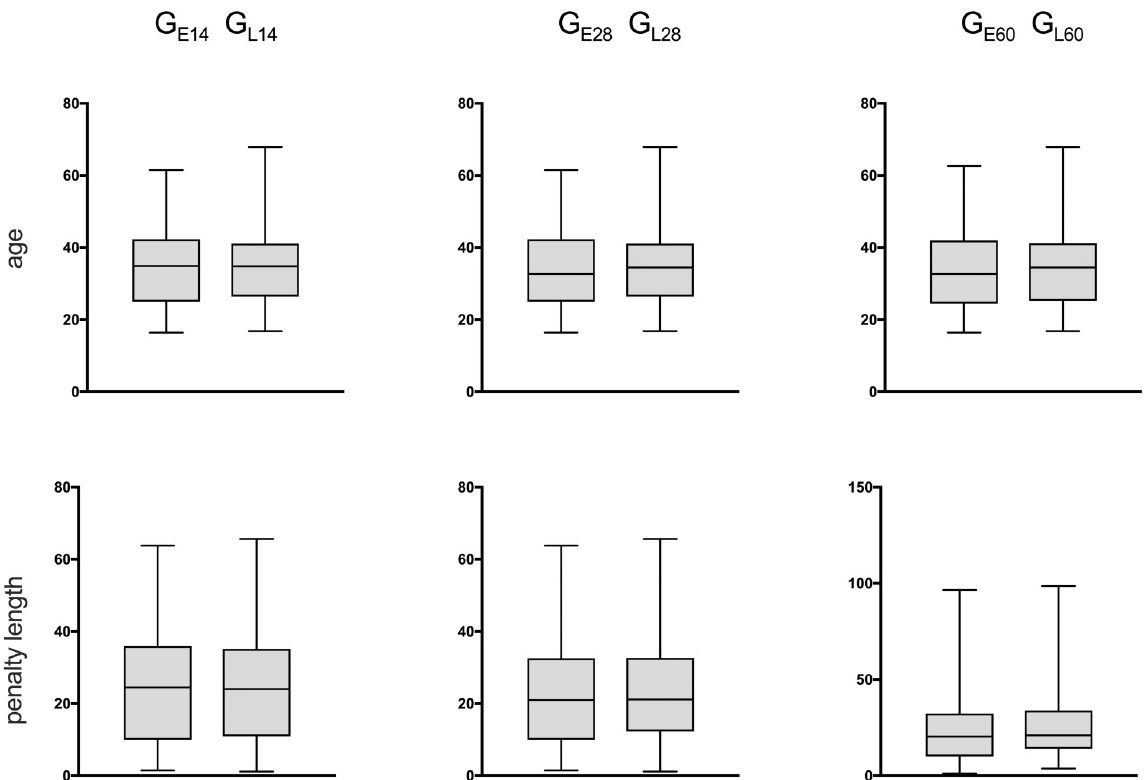
Fig 1. Characteristics of the matching procedure. For each time point examined (14 days, 28 days, and 60 days after entering imprisonment), a group of early (GE) and late suicide (GL) events were matched according to age and penalty length, resulting in three pairs (GE14/GL14; GE28/GL28; GE60/GE60). For each group, box and whisker graphs are given, representing minimum and maximum values, 25th/75th percentiles, and mean